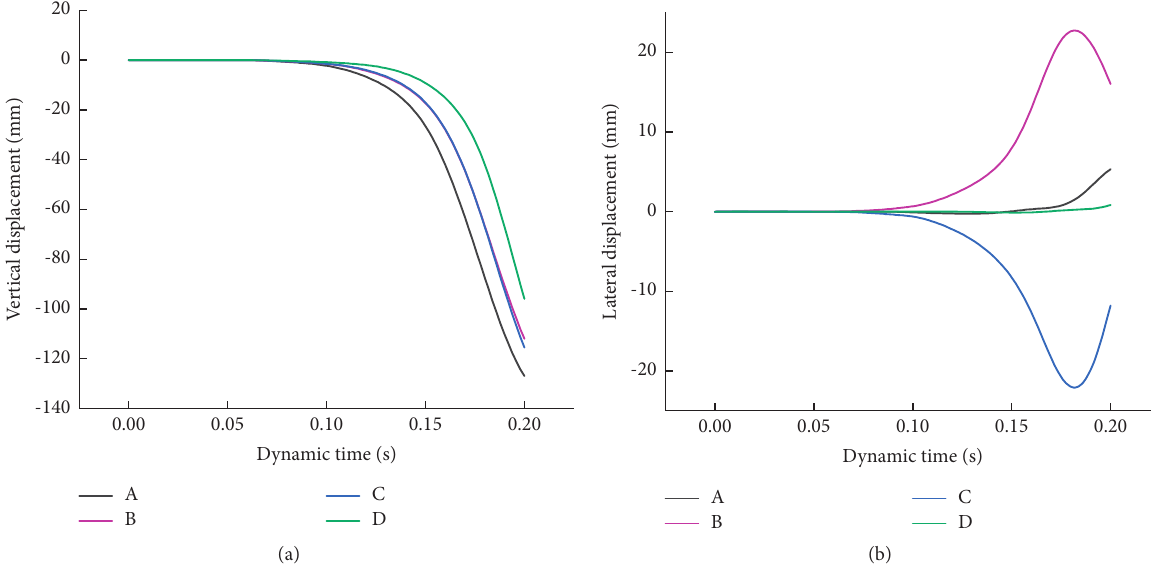
Figure 7: Time-history curves of the displacement of tunnel monitoring points. (a) Vertical displacement. (b) Lateral displacement.